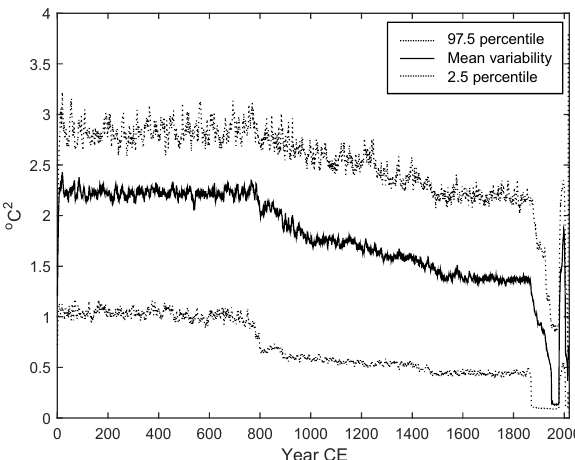
Figure B1. Time variability in spatially averaged intra-ensemble variance of the Arctic2k reconstruction together with the respective ensemble-based 95%